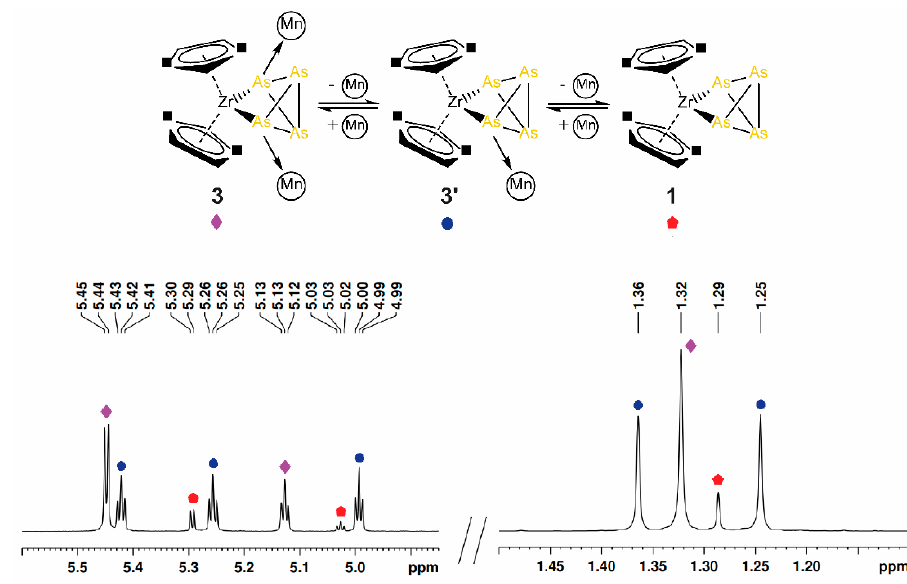
Figure 4. Sections of the 1 H NMR spectrum of 3 at 293 K in C 6 D 6 with assignment to the com- pounds present in solution.